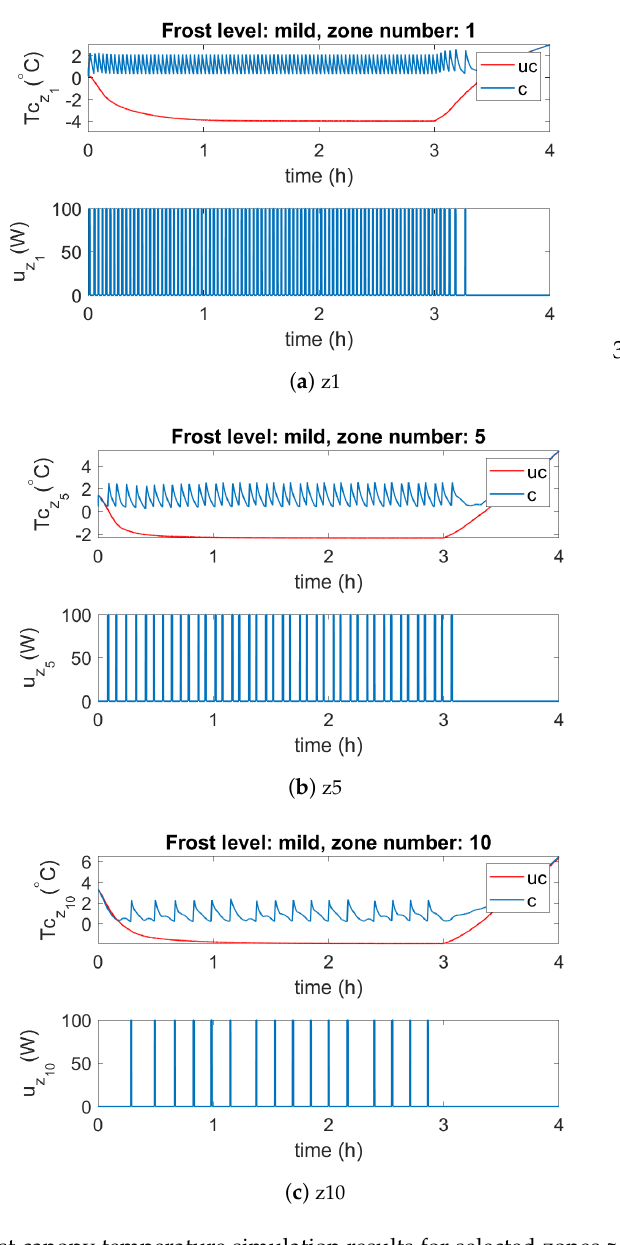
Figure 6. Mild frost canopy temperature simulation results for selected zones z 1 , z 5 , and z 10 . Here, “uc” and “c” denote uncontrolled and controlled cases,